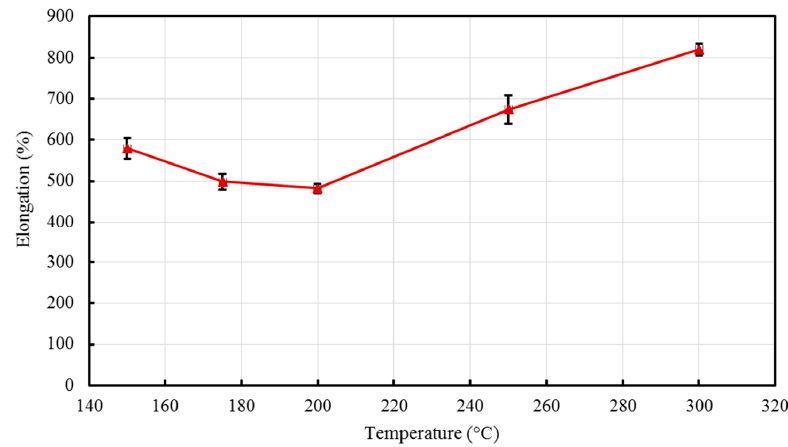
Figure 10. Effect of barrel temperature on percent elongation of the developed HDPE-TiO 2 nanocomposites (SE bars included).